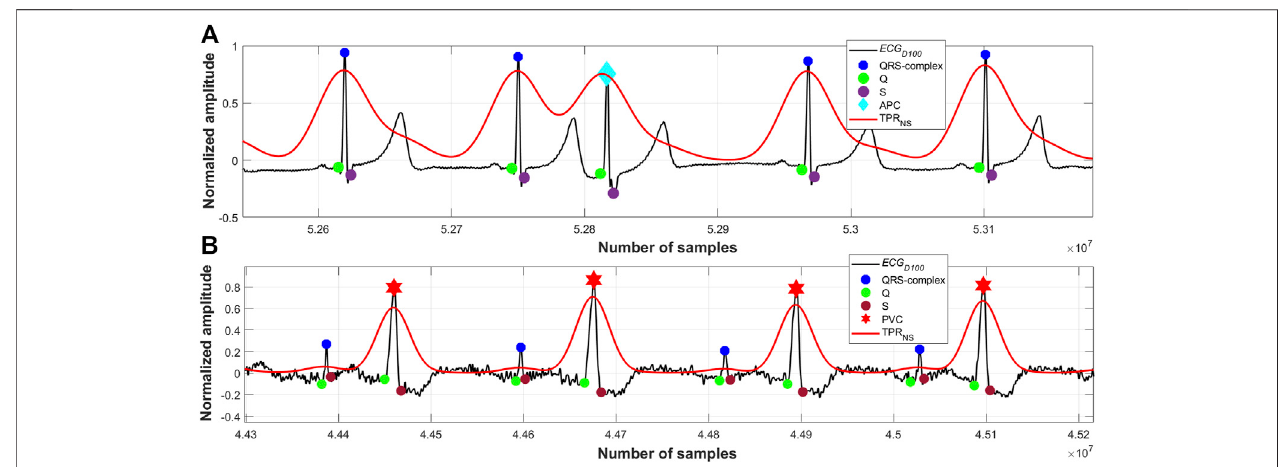
FIGURE 8 | (A) Detected QRS-complexes and APC beats; record #113m, MITDB, (B) detected QRS-complexes and PVC beats; record #228m, MITDB.